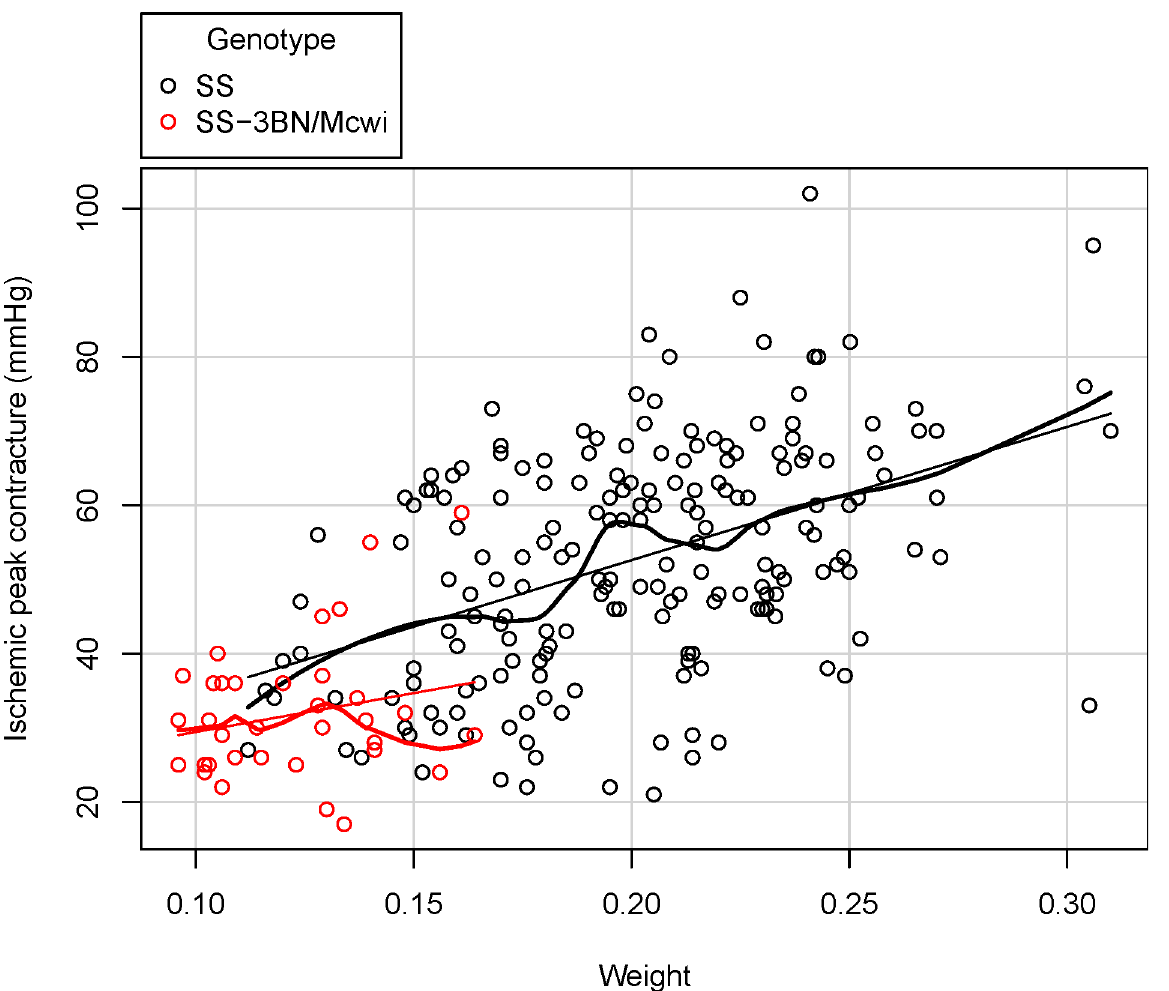
Fig 9. Example output of the PhenStat scatterplotGenotypeWeight function. Data shown is the output from the scatterplotGenotypeWeight function during analysis of the ischemic peak contracture pressure from a study on rats comparing SS strain to SS-3BN/Mcwi strain. Both a regression line and a loess line (locally weighted line) fitted for each